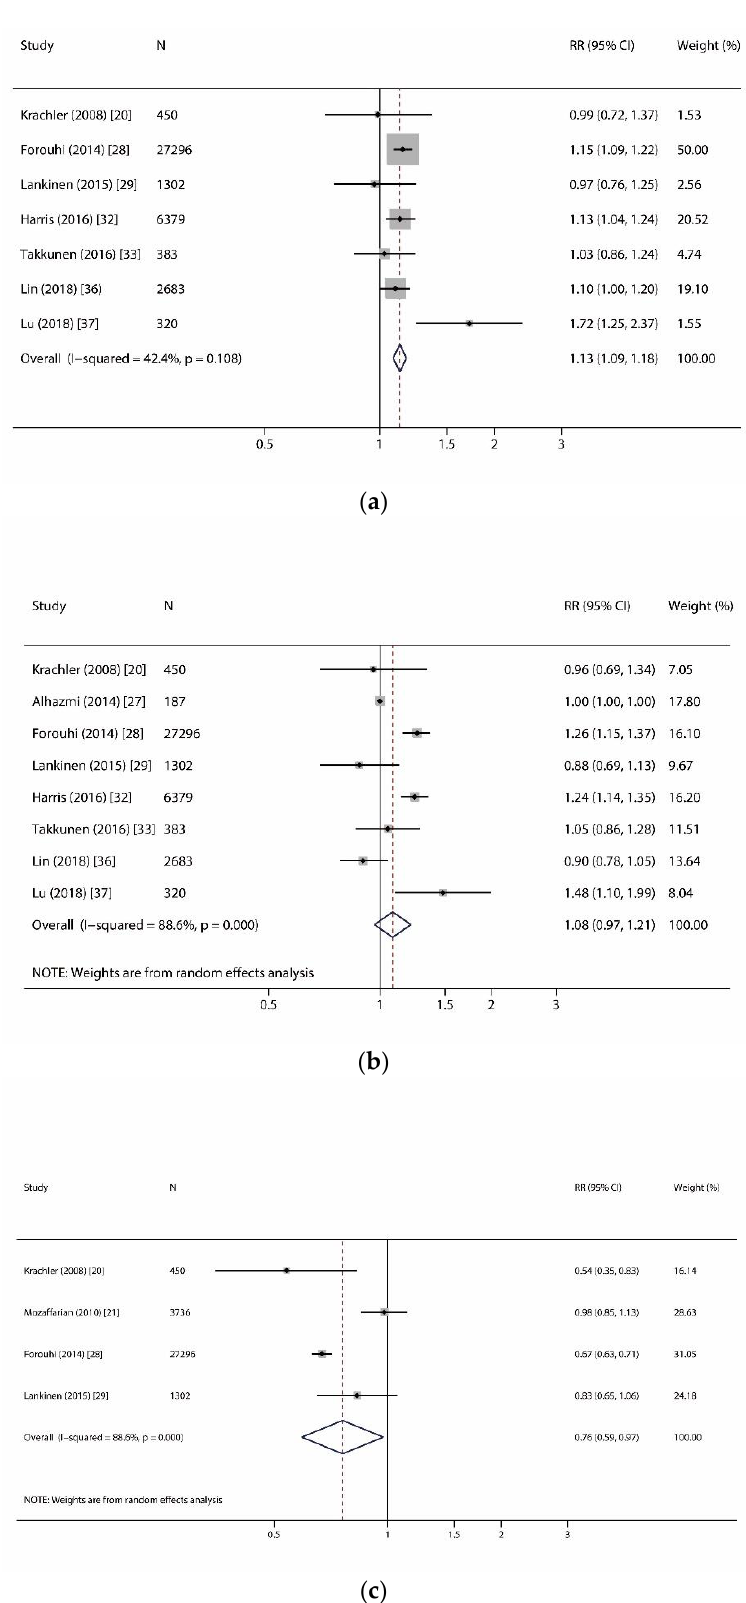
Figure 3. Forest plots of studies investigating the relationship of even-chain saturated fatty acids and incident type 2 diabetes. ( a ) Forest plot for myristic acid (C14:0); ( b ) Forest plot for palmitic acid (C16:0); ( c ) Forest plot for stearic acid (C18:0). RR: relative risk; CI: confidence interval.